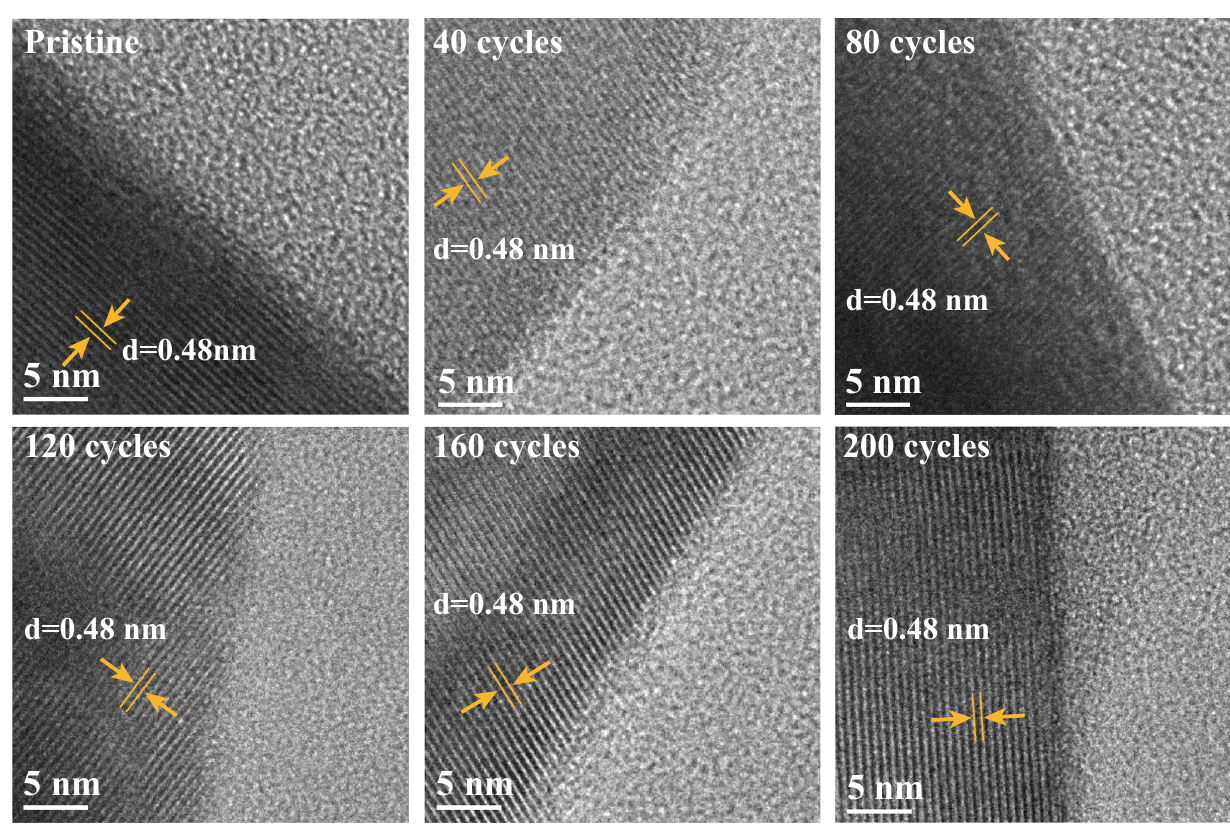
Fig. 3 TEM images of crystal surfaces of LiMn 2 O 4 /C after different cycles in 10 mM LiCl